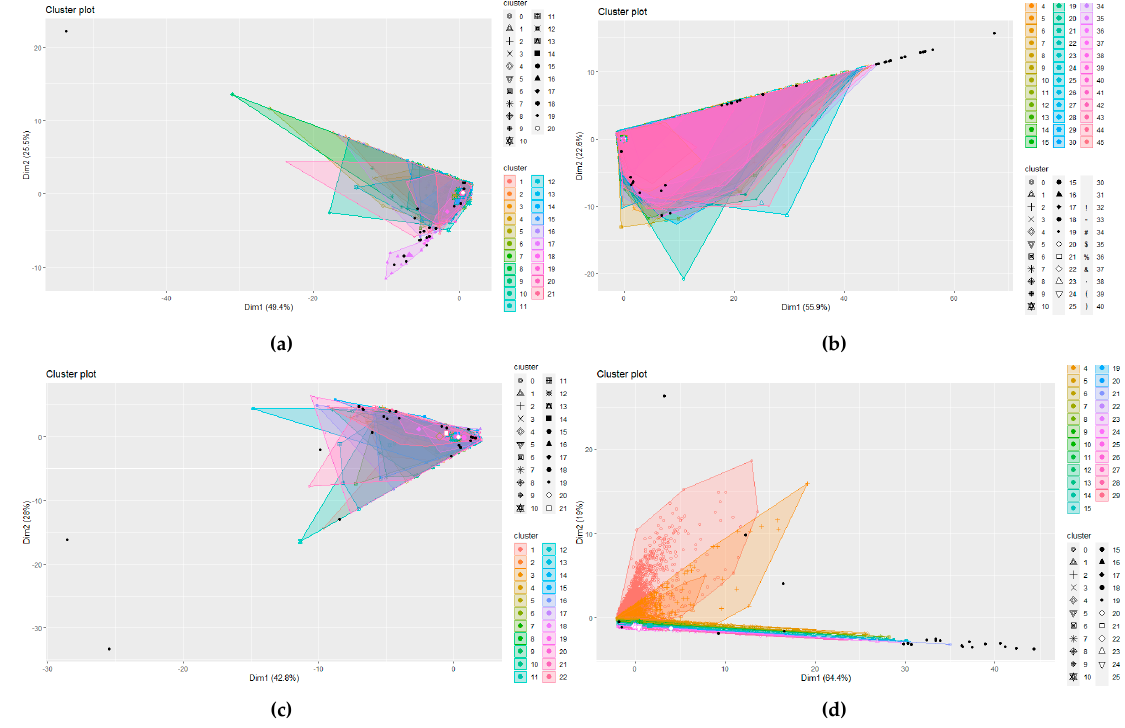
Figure 7. DBSCAN Benchmark. ( a ) Device ID, ( b ) Patient ID, ( c ) Routine ID, and ( d ) User ID.